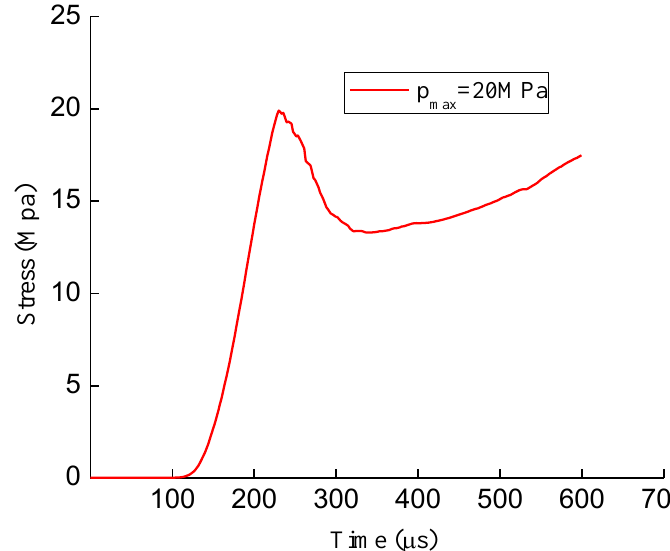
Figure 19. Time-history curve of coal seam stress in a 2D model.